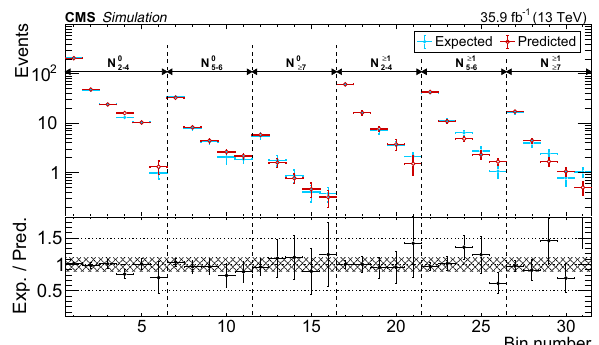
Fig. 2 The lost-lepton and τ h event yields as predicted directly from simulation in the signal regions, shown in red, and from the prediction procedure applied to simulated e γ or μγ events, shown in blue. The error bars correspond to the statistical uncertainties from the limited number of events in simulation. The bottom panel shows the ratio of the simulation expectation (Exp.) and the simulation-based prediction (Pred.). The hashed area shows the expected uncertainties from data- to-simulation correction factors, PDFs, and renormalization and fac- torization scales. The categories, denoted by dashed lines, are labeled as N b , where j refers to the number of jets and b refers to the num- j ber of b-tagged jets. The numbered bins within each category are the various p miss bins. In each of these regions, the first bin corresponds T < 200GeV, which belongs to a control region. The to 100 < p miss T remaining bins correspond to the signal regions in Table